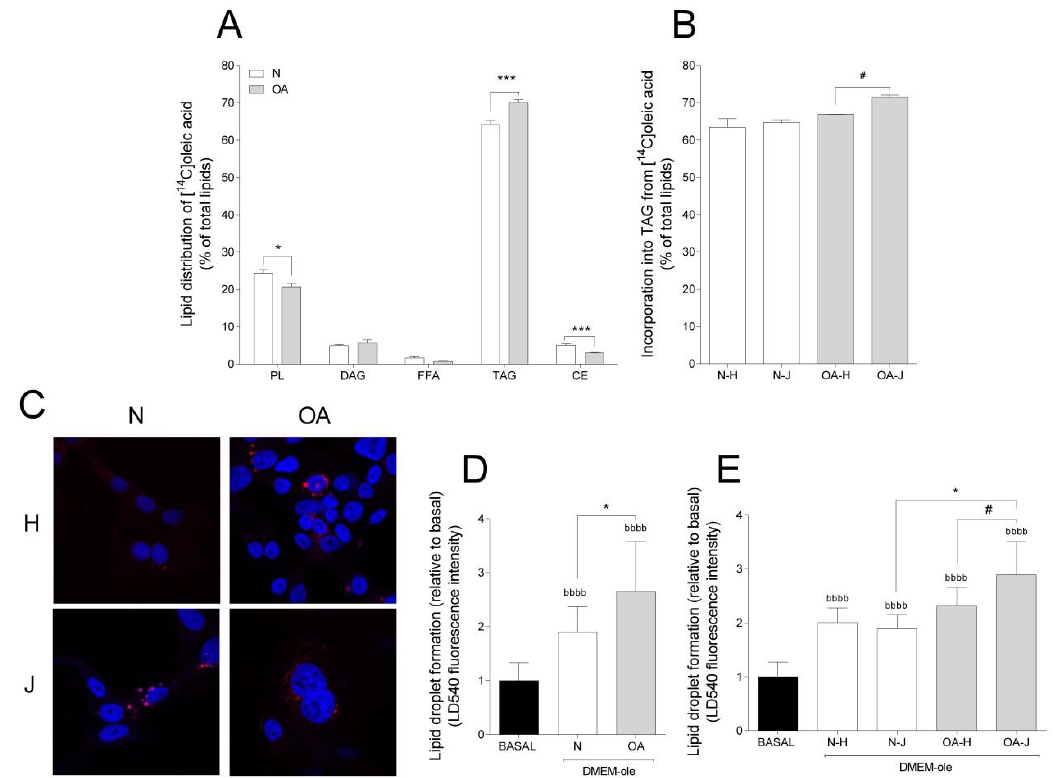
Figure 4. Lipid distribution and lipid droplet formation. ( A ) Lipid distribution in healthy (N) and osteoarthritis (OA) cybrids after 24 h incubation with [1- 14 C]oleic acid. PL, phospholipid; DAG, diacylglycerol; FFAs, free fatty acids; TAG, triacylglycerol; CE, cholesteryl ester. ( B ) Incorporation of [1- 14 C]oleic acid into TAG in N and OA cybrids carrying haplogroup H or J. ( C ) One representative image of cybrids after culturing in DMEM-ole (i.e., DMEM no glucose supplemented with 100 mM oleic acid) for 48 h before staining lipid droplets with LD540 (red) and nuclei with Hoechst 33,258 (blue). ( D , E ) Quantification of lipid droplet formation by flow cytometry in N and OA cybrids ( D ), carrying haplogroups H or J ( E ) relative to basal (DMEM 25 mM glucose). N and OA data included the values for haplogroups H and J combined. All data were obtained from three independent experiments, each with at least three replicates and two clones per donor. Values are presented as mean ± SEM relative to total lipids (A and B) or relative to basal (D and E). * Statistically significant di ff erence between N and OA cybrids (* p ≤ 0.05, *** p ≤ 0.001, unpaired t -test). # Statistically significant di ff erence between haplogroups ( # p ≤ 0.05, Mann–Whitney test). b Statistically significant versus basal ( bbbb p ≤ 0.0001, paired t